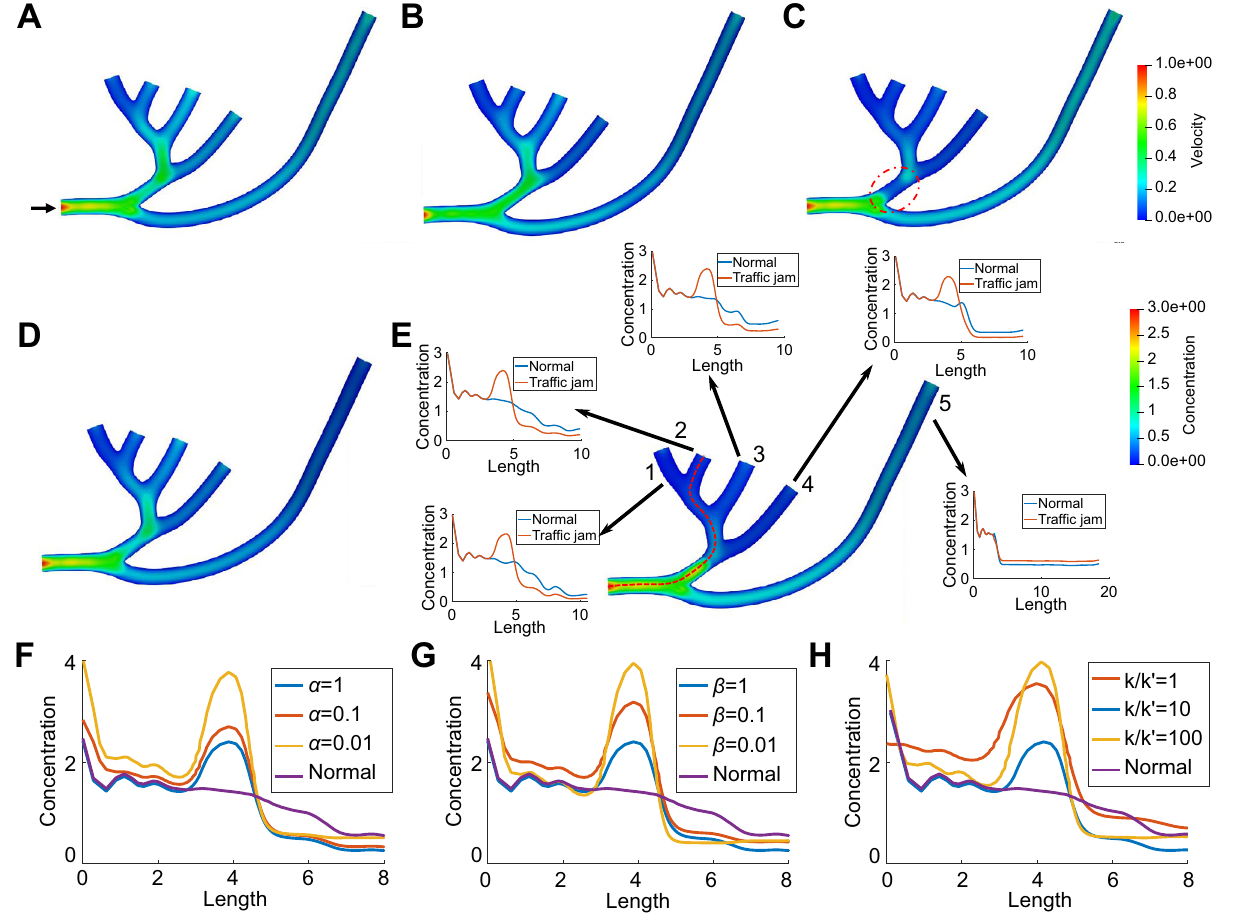
Figure 3. Simulation of material transport and parameter analysis in a neuron tree extracted from NMO_54504. ( A ) The predefined velocity field V + . Black arrow points to the inlet of the neuron tree. The computed velocity field in ( B ) a healthy neuron and ( C ) an abnormal neuron with reduced MTs in the red dashed circle region. Distribution of concentration ( n 0 + n + ) in ( D ) a healthy neuron and ( E ) an abnormal neuron. We also compare the concentration curve on the centerline from the inlet to every outlet between normal and abnormal transport in ( E ). The red dashed curve shows the centerline from the inlet to one of the outlets and each outlet is indexed by a unique number. ( F – H ) The concentration curve ( n 0 + n + ) on the centerline from inlet to outlet 2 affected by different settings of ( F ) α ; ( G ) β ; and ( H ) k / k ′ . Unit for color